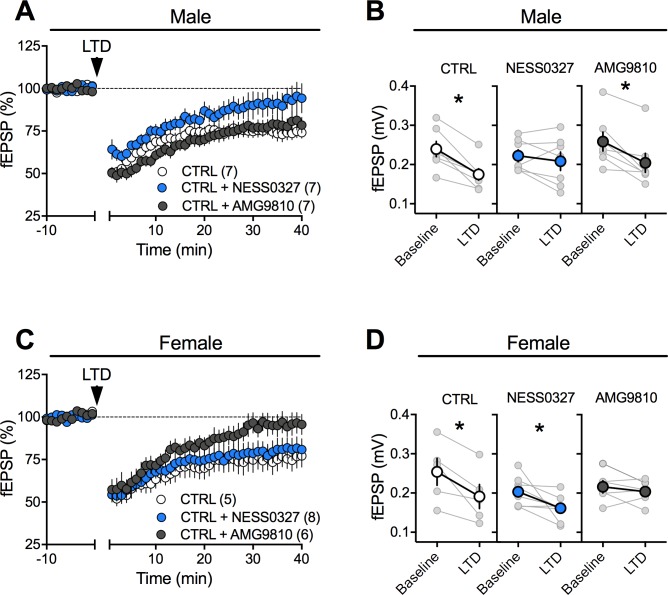
Sex-specific substrates of LTD in naïve adult mPFC.(A) Time course of normalized field EPSPs recordings from layer 5 mPFC after 10 Hz stimulation protocol (10 min, arrow) in presence of the selective CB1R antagonist NESS0327 (n = 7, blue circles) or TRPV1 antagonist AMG9810 (n = 7, grey circles) in naïve male rats. (B) Individual experiments (grey) and group average (tan circles), before (baseline) and after (40 min) LTD induction (arrow) showing that, in control male rats (CTRL, left), LTD is blocked by the CB1R antagonist (NESS0327, middle) but not by the TRPV1 antagonist (AMG9810, right). In control rats: 0.239 ± 0.019 mV before LTD versus 0.175 ± 0.015 after LTD induction (n = 7; p<0.05, paired t-test). After NESS0327 preincubation: 0.223 ± 0.015 mV before LTD versus 0.208 ± 0.024 after LTD induction (n = 7; p>0.05, paired t-test). In naive males, LTD induction did not require activation of TRPV1 receptors: 0.258 ± 0.024 mV before LTD versus 0.204 ± 0.024 after LTD induction (n = 7; p<0.05, paired t-test). (C) Time course of normalized field EPSPs recordings from layer 5 mPFC after 10 Hz stimulation protocol (10 min, arrow) in presence of CB1R antagonist NESS0327 (n = 8, blue circles) or TRPV1 antagonist AMG9810 (n = 6, grey circles) in naive female rats. (D) Individual experiments (grey) and group average (colors), before (baseline) and after (40 min) LTD induction showing that LTD in control female rats is TRPV1R-mediated (right) rather than CB1R-mediated (middle). Low-frequency stimulation of mPFC slices triggers LTD in female (left, white): 0.254 ± 0.034 mV before 10 Hz stimulation versus 0.191 ± 0.031 after LTD induction (n = 5; p<0.05, paired t-test). This LTD is blocked by TRPV1R antagonist AMG9810: 0.216 ± 0.016 mV before and 0.204 ± 0.012 after LTD induction (n = 6; p>0.05, paired t-test). In contrast, in female rats, LTD is not blocked by CB1R antagonist: 0.204 ± 0.013 mV before LTD versus 0.162 ± 0.011 after LTD induction (n = 8; p<0.05, paired t-test). mPFC slices were preincubated for 45 min in 1 μM NESS0327 and 3 μM AMG9810. *p<0.05. n = individual rats. Error bars indicate SEM. Scale bar: 10 ms, 0.1 mV.